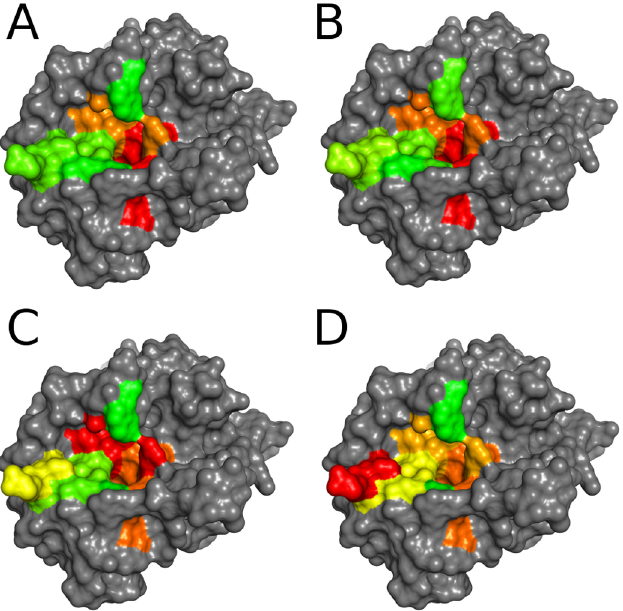
Fig 2. Flexibility landscapes of the thrombin binding site in comparison with cleavage entropy. Cleavage entropy mapped to thrombin sub-pockets (A) with colors ranging from red (specific) to green (unspecific) in comparison with sub-pocket average global backbone B-factors (B), φ entropy (C) and ψ entropy (D) with colors ranging from red (rigid or low dihedral entropy, respectively) to green (flexible or high dihedral entropy, respectively). Flexibility metrics in (B) and (C) show good correlation with (A). In contrast to other flexibility metrics, the S6 sub-pocket appears rigid according to ψ entropy (D). See Figure A in S1 File for a mapping based on ranks rather than absolute